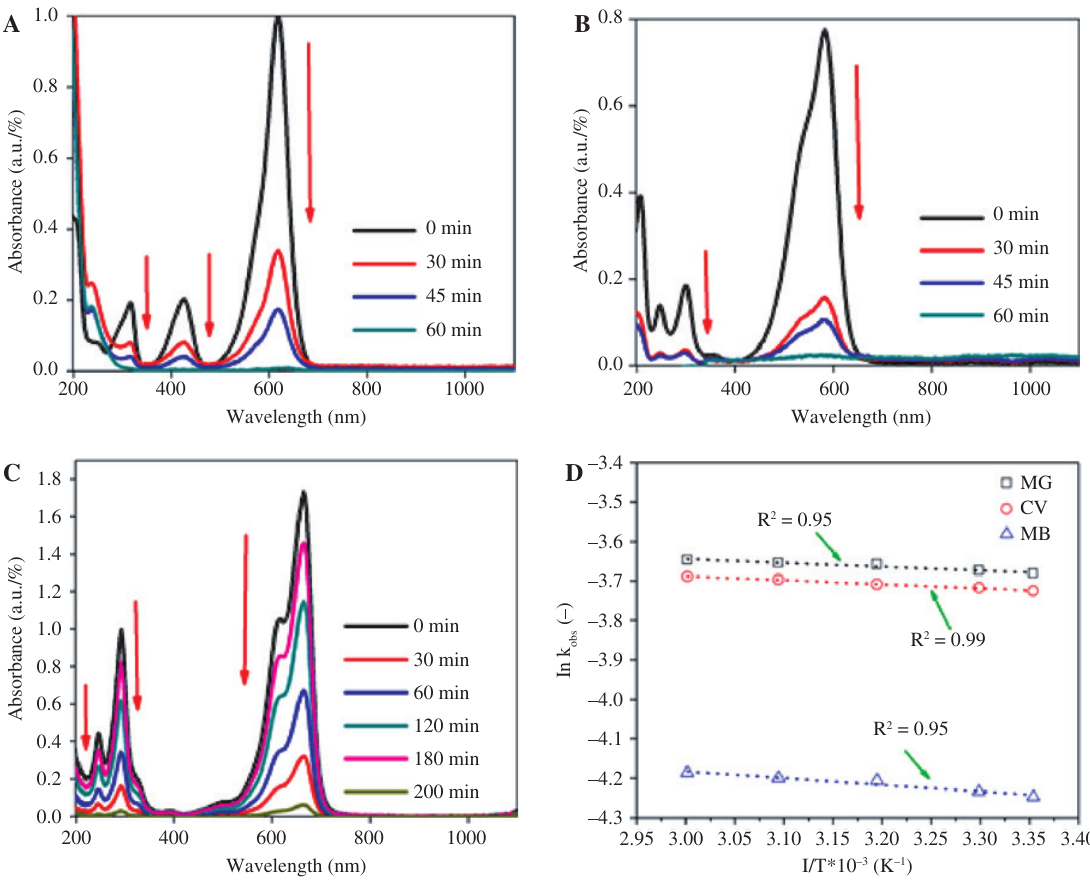
Figure 13: The UV–vis spectra of the degradation of (A) malachite green (MG), (B) crystal violet (CV) and (C) methylene blue (MB) dyes using the phytogenic magnetic nanoparticles (PMNPs) at various times; and (D) linear plots of lnK and MB dyes by the PMNPS at various reaction